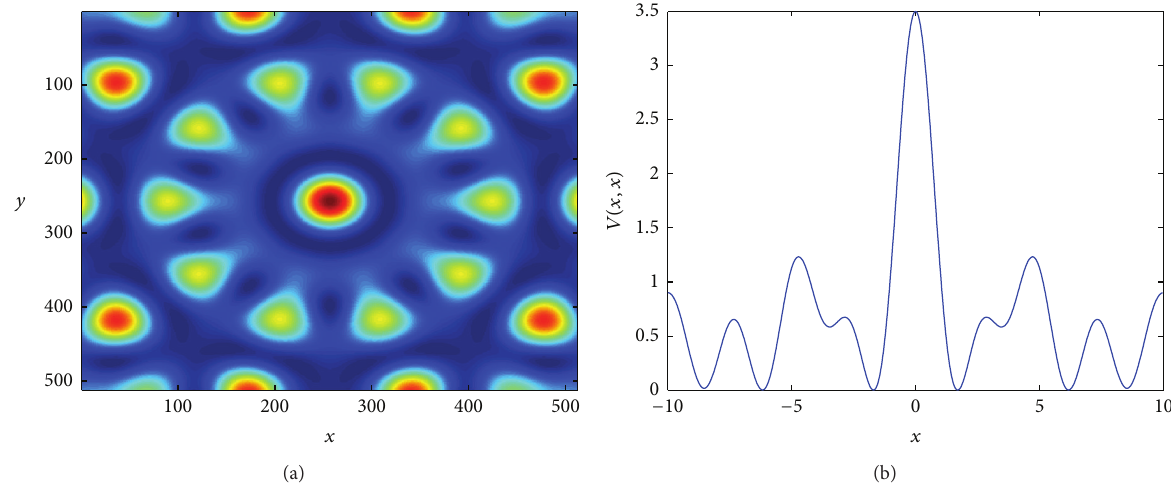
Figure 1: (a) Contour image of the Penrose potential with 𝑉 0 = 3.5 , 𝐾 = 1 . (b) Cross section of the Penrose potential along diagonal axis.